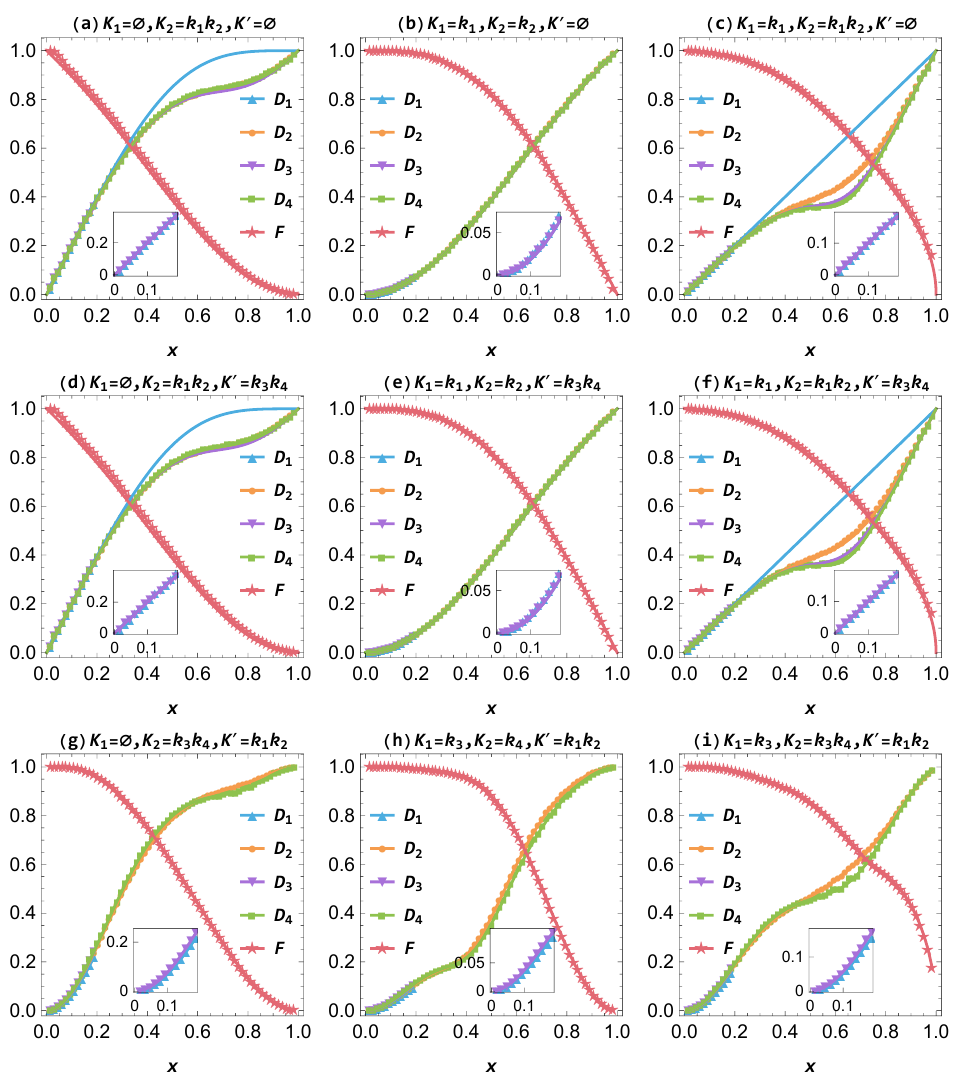
Figure 3 . Checks of the first conjecture (2.14), (2.15) and (2.16) (the first row), the second conjecture (2.19), (2.20) and (2.21) (the second row), and the third conjecture (2.23), (2.24) and (2.25) (the third row) in the nearest-neighbor coupled fermionic chain. In each panel, the symbols are numerical results for the trace distance D ( ρ ) , the normalized fer 1 ≡ D A,K 1 ∪ K 0 , ρ A,K 2 ∪ K 0 1 Schatten distance D ( ρ ; ρ ) with n = 2 , 3 , 4 , and the fidelity F ≡ fer n ≡ D A,K 1 ∪ K 0 , ρ A,K 2 ∪ K 0 A,K 0 n ) , among which D and D are from the canonicalized correlation matrix F fer ( ρ A,K , ρ A,K 1 3 1 ∪ K 0 2 ∪ K 0 method and D , D and F are from the recursive correlation matrix method. In the first and the 2 4 second rows, the solid lines are the analytical conjectured results from the subsystem mode method in the free fermionic chain. In the third row, the solid lines are the numerical conjectured results in the nearest-neighbor coupled fermionic chain. In each panel, we give the inset with the results of ) + L and ( k ) = ( 1 ) . For the analytical D 1 and D 3 . We have set γ = λ = 1 , ( k 1 , k 2 ) = ( 1 , 3 , 3 3 , k 4 2 2 4 2 2 results in the first and second rows we have set L = + ∞ , and for all numerical results we have set L = 64